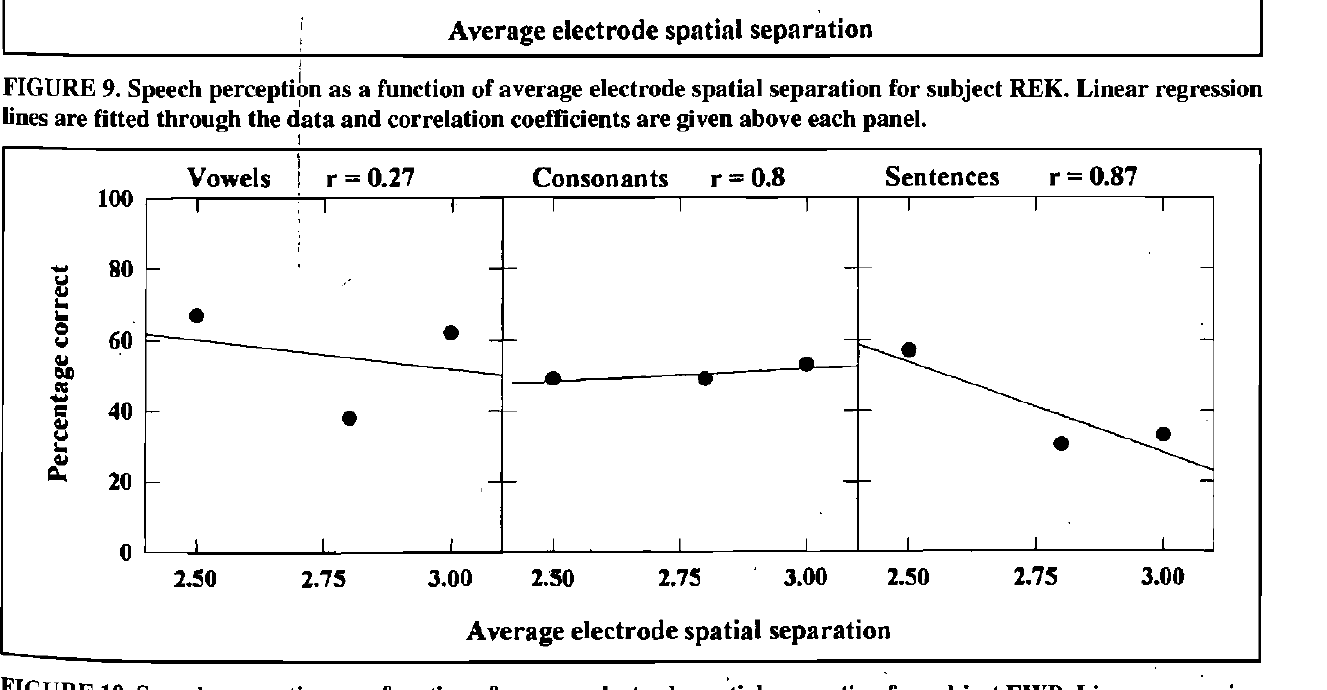
FIGURE 10. Speech perception as a function of average electrode spatial separation for subject EWB. Linear regression lines are fitted through the data and correlation coefficients are given above each